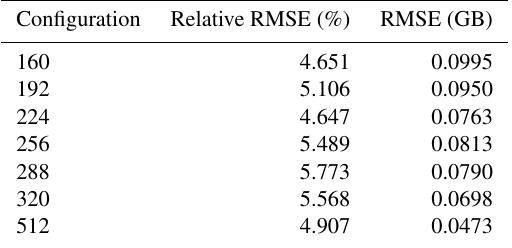
Table 8. Evaluation of the memory model accuracy. The first col- umn reports the examined decompositions, the last one shows the root mean square error (RMSE), expressed in GigaBytes, while the second one shows the relative RMSE expressed as the root mean square error compared with the average of the examined sample.